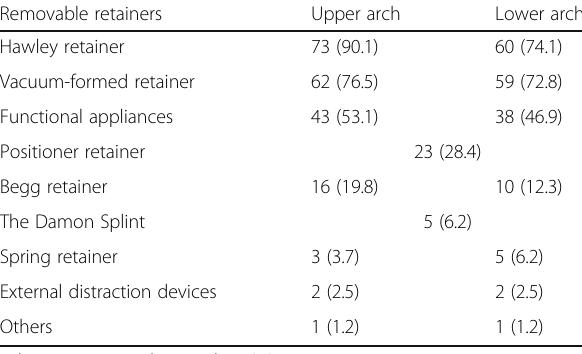
Table 4 Respondents who used removable retainers Removable retainers Upper arch Lower arch